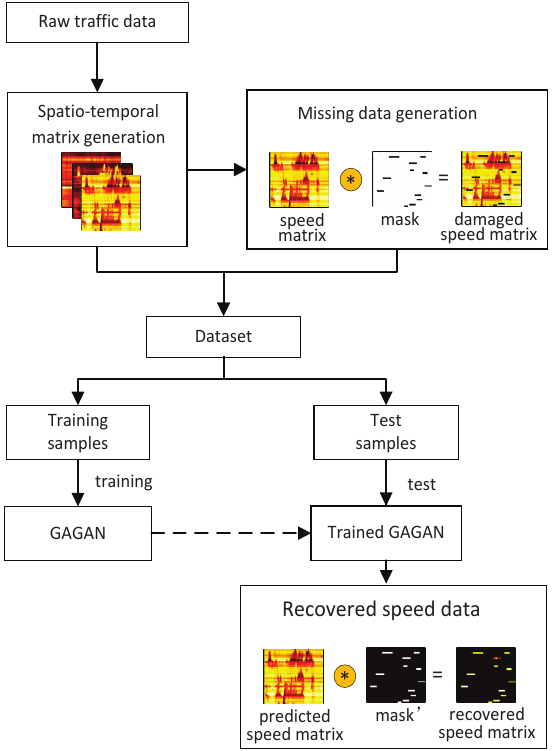
Figure 1. The system architecture of traffic speed imputation using